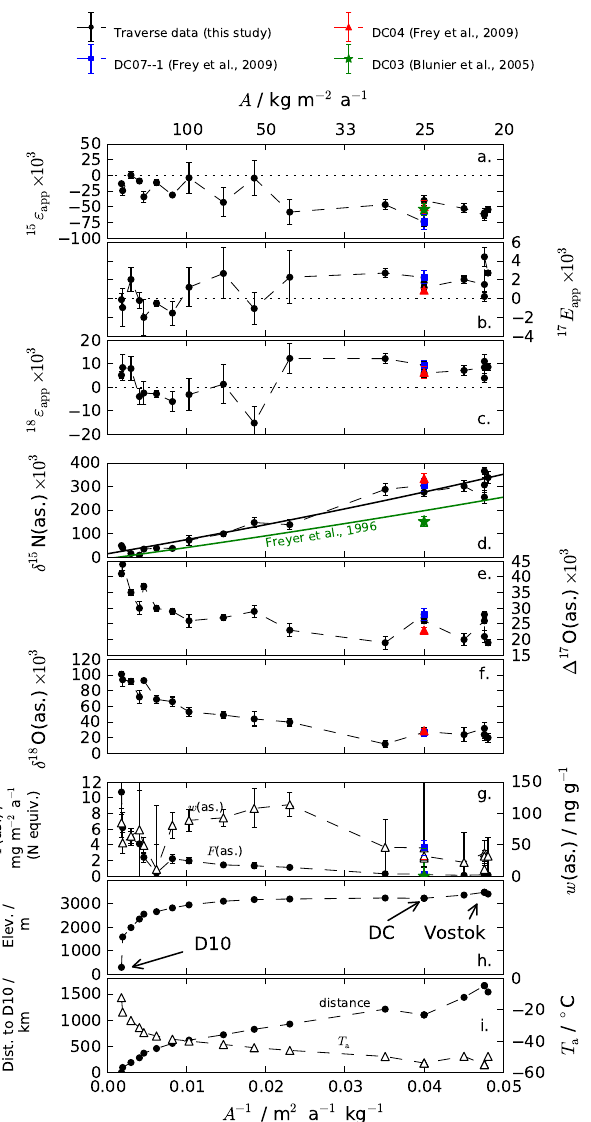
Fig. 4. Reduced data for the snow pits collected in East Antarc- tica plotted as a function of the snow accumulation rates (top x- axis) and their inverse (bottom x-axis). (a–c) 15 N/ 14 N, 17 O excess and 18 O/ 16 O apparent fractionation constants ( 15 ε app , 17 E app and 18 ε 15 N, 1 17 O and δ 18 O val- app , respectively). (d–e) Asymptotic δ ues. The solid lines in (d) are fits to the data of this study (black) and those of Freyer et al. (1996) (green) following the approach of the latter authors. (g) Asymptotic nitrate mass flux ( F (as.), the down- ward nitrate mass flux which escapes the photic zone) and mass fractions w (as.), (h) site’s elevation and (i) site’s distance to D10 and mean annual temperature T a . Data for previously published pits are marked by a blue square (DC07-1, Frey et al., 2009), a red trian- gle (DC04, Frey et al., 2009) and a green star (Blunier et al., 2005).